Question: What visual encoding does this figure use to show its data?
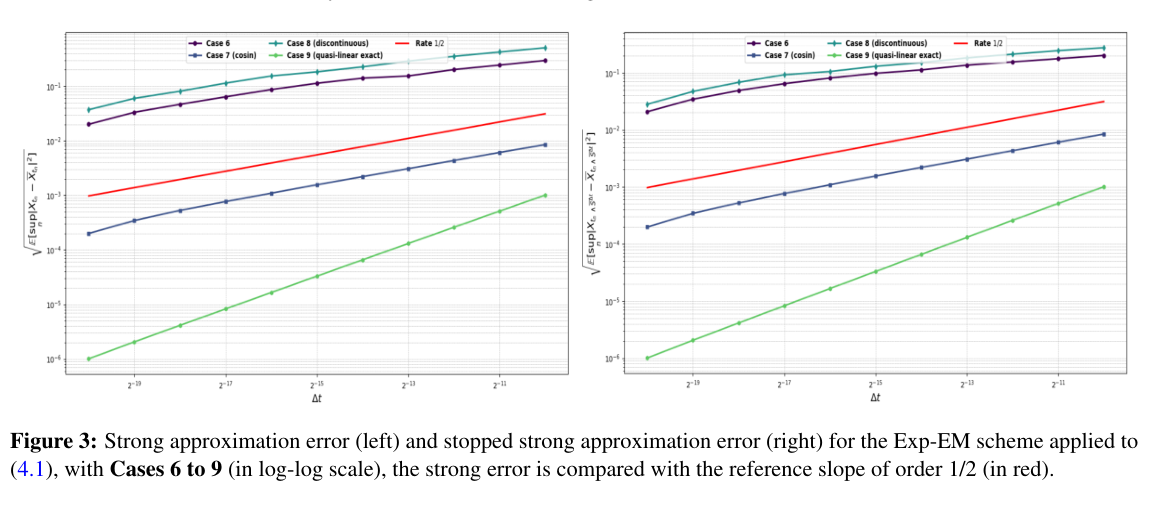
Answer: line